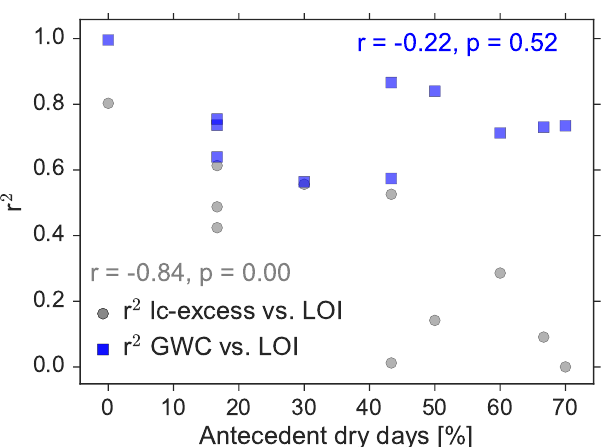
Figure 6. Relationship between coefficient of determination of the relationship between lc-excess and LOI (gray) and GWC and LOI (blue) with the percentage of dry days during the 30-day period prior to the soil